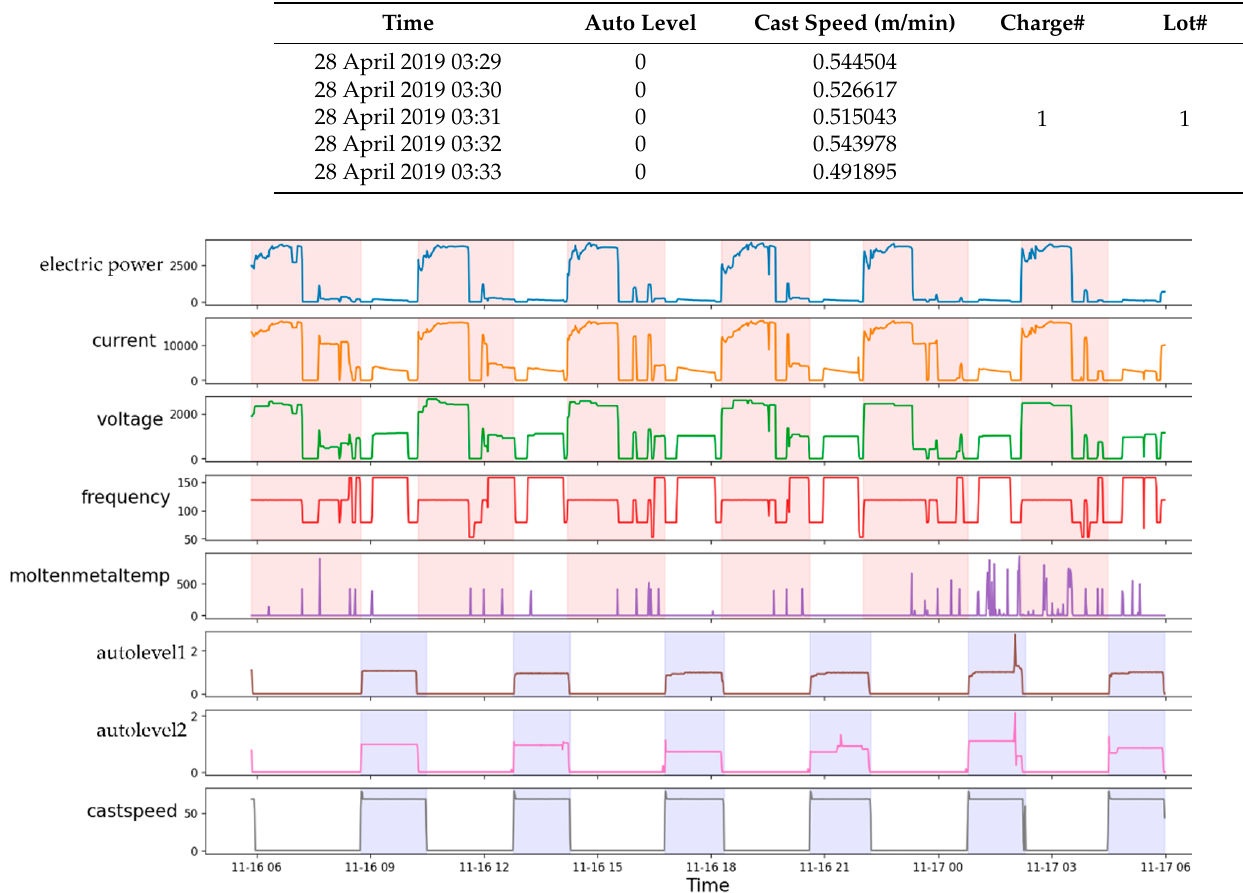
Table 3. Extracted TSWP for casting process.